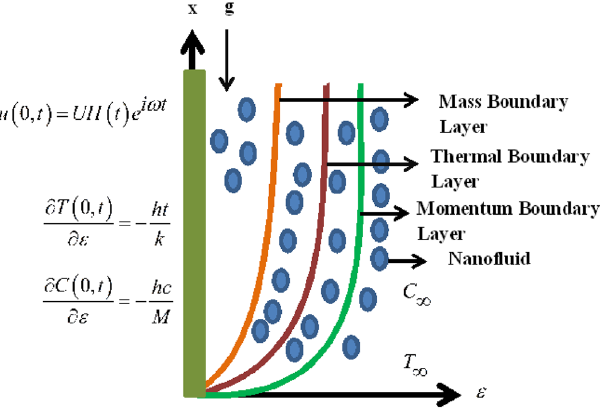
Figure 1. Sketch of the flow